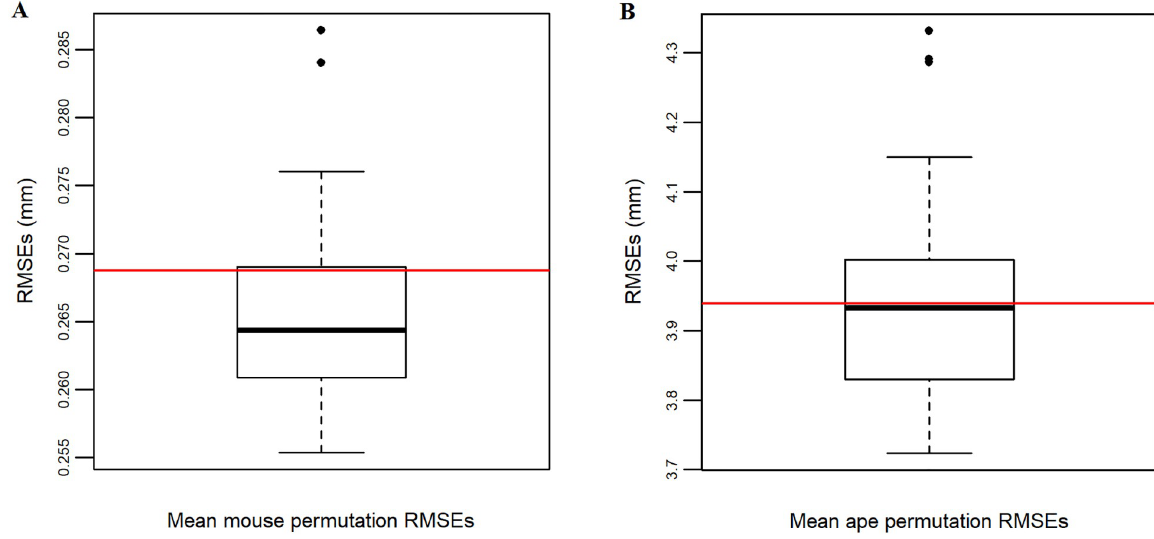
Fig 9. Permutation analyses for evaluating the performance of the K-means template selection method. (A) The boxplot shows the mean RMSEs of the 100 MALPACA runs from the mouse permutation analysis. The red horizontal line represents the mean RMSE from the mouse K- means based MALPACA. (B) The boxplot shows the mean RMSEs of the 50 MALPACA runs from the ape permutation analysis. The red horizontal line represents the mean RMSE from the ape K-means based MALPACA.